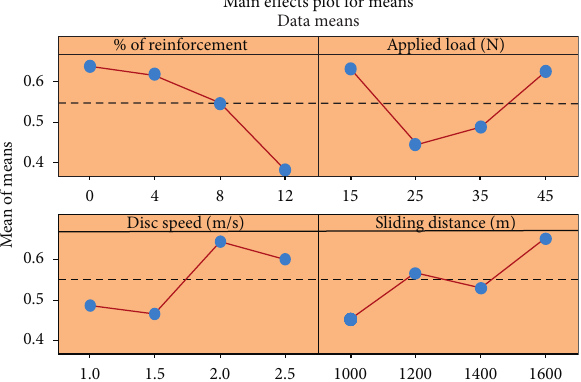
Figure 5: Main effects plot for means (wear